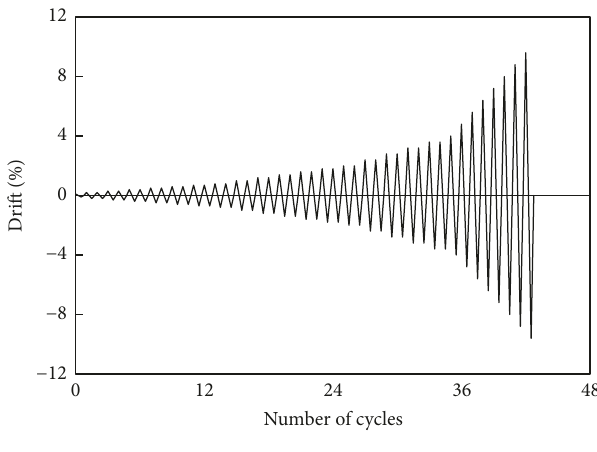
Figure 6: Loading history.